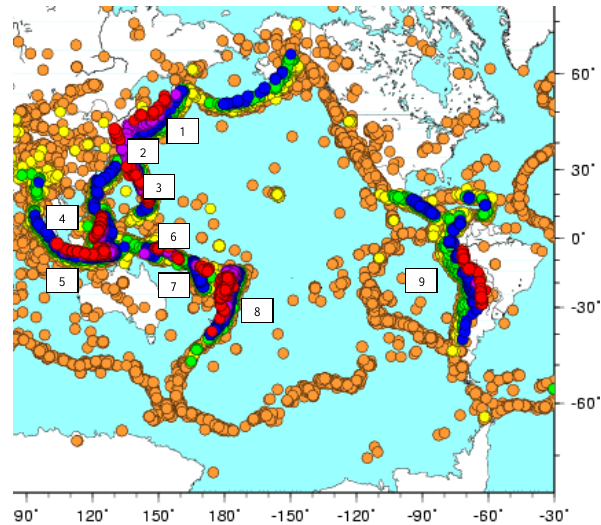
Fig. 1. Distribution of EQs ( M ≥ 5) in the Pacific region (USGS catalogue). Hypocentres of deep EQs (depth d > 500km) are shown by red circles, EQs for 300 ≤ d ≤ 500km are shown by magenta circles, EQs for 150 ≤ d ≤ 300km are blue , EQs for 150 ≤ d ≤ 70 are green, EQs for 33 ≤ d ≤ 70km are yellow and brown colour correspond the crustal EQs. Selected zone for analysis are labelled by figures: (1) – Kurile-Kamchatka, (2) – Japan, (3) – Mariana, (4) – Philippines, (5) – Sunda, (6) – Bougainville (Solomon sea), (7) – Tonga N. (North Tonga-Kermadec), (8) – Tonga S. (South